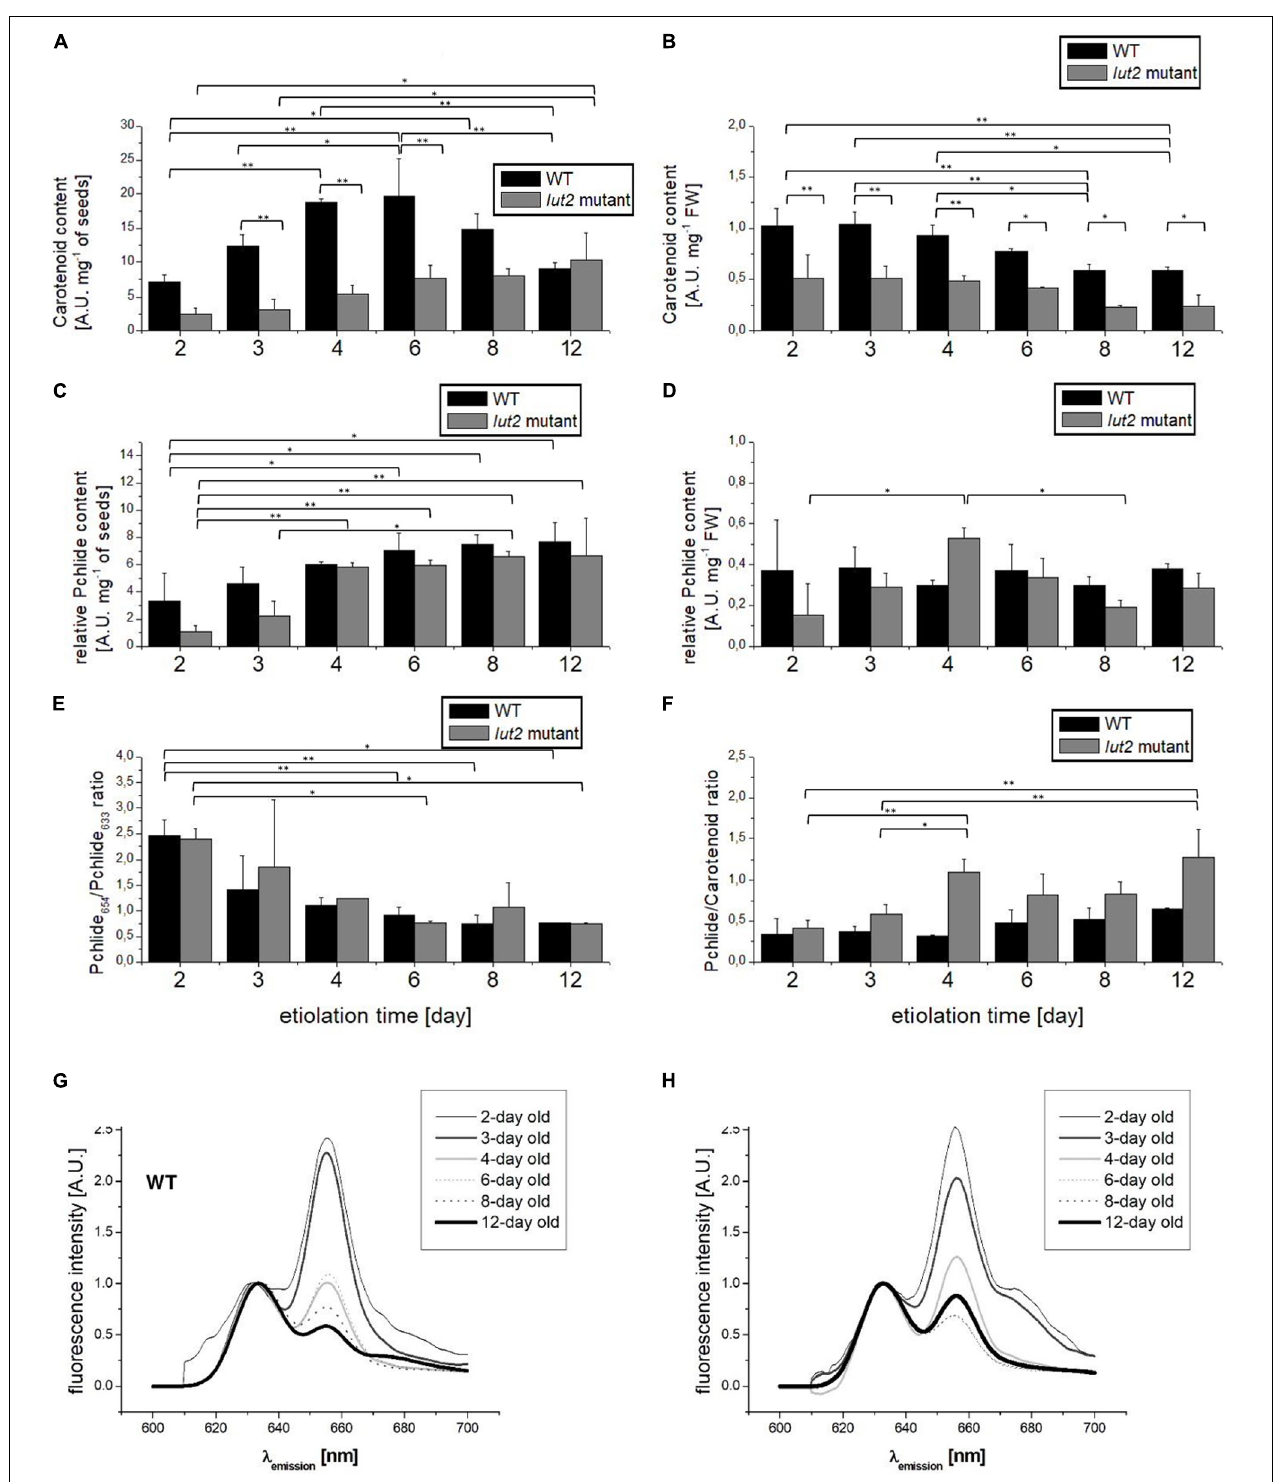
FIGURE 3 | Analysis of pigments in etiolated seedlings. (A,B) Total carotenoid content normalized to seed weight or to seedling FW. (C,D) Total Pchlide content estimated fluorometrically and normalized to seedling weight or to fresh weight of seedlings. (E) The Pchlide 654 /Pchlide 633 ratio measured at 77K. (F) The ratio between total Pchlide and carotenoid content. (G,H) Representative comparison of Pchlide emission spectra ( λ exc = 440 nm) from etiolated seedlings of WT and lut2 mutant at different ages, measured at 77K and normalized at 633 nm. Bar heights represent arithmetic mean, while error bars represent SD; n = 4. Statistically significant differences from two-way ANOVA and post hoc Tukey test were indicated using ∗∗ p < 0.01 and ∗ p < 0.05.